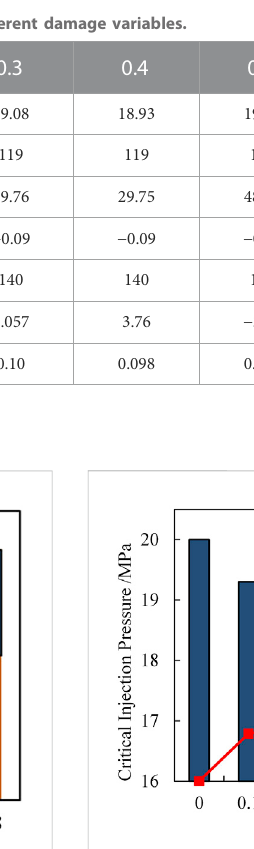
FIGURE 8 Critical injection pressure for the WIF propagation with different damage